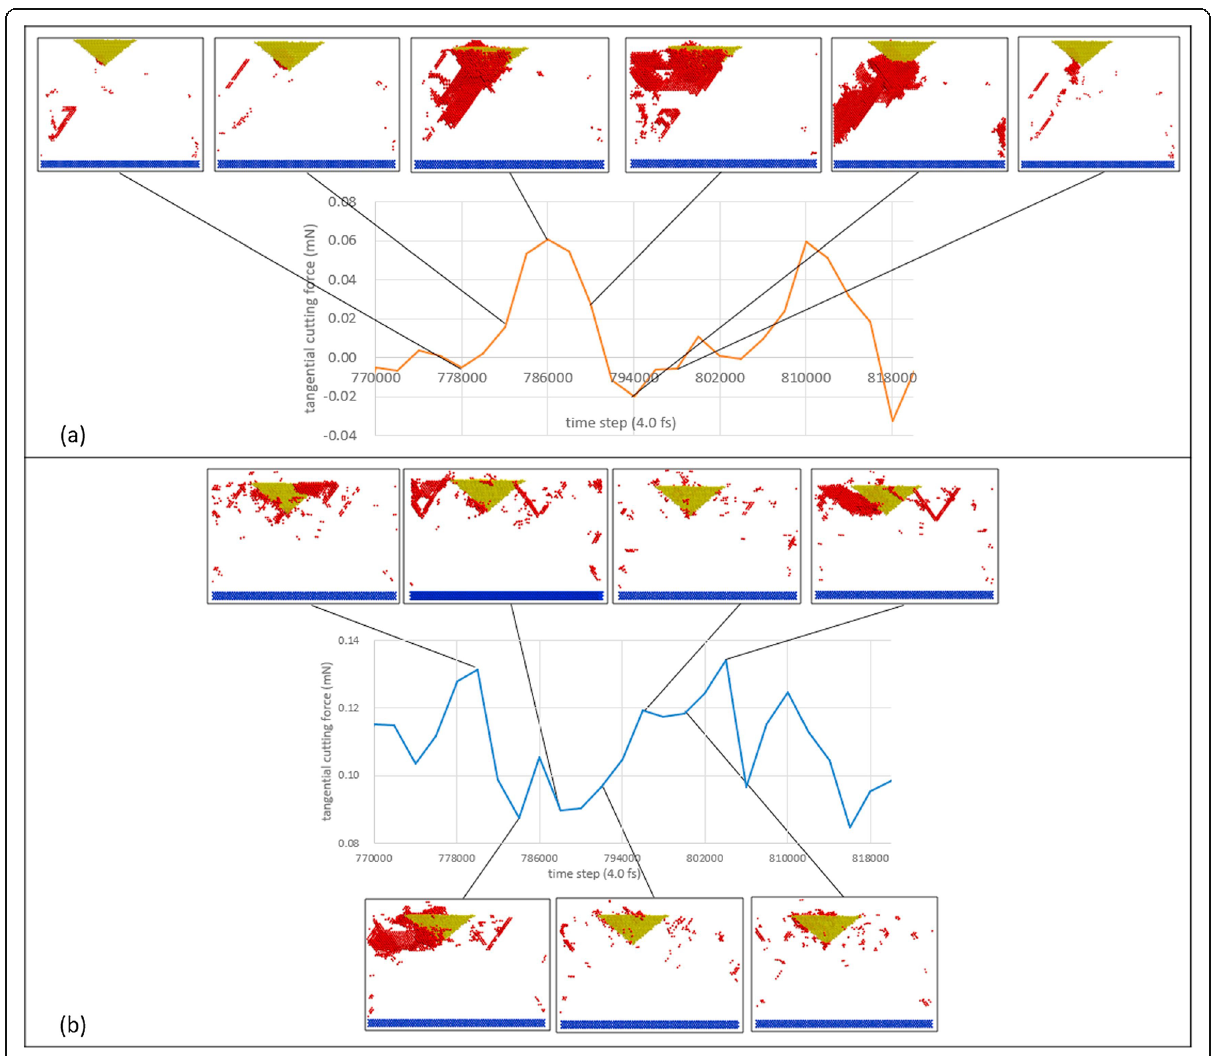
Fig. 5 Slipping processes in a dynamic ploughing and b static ploughing